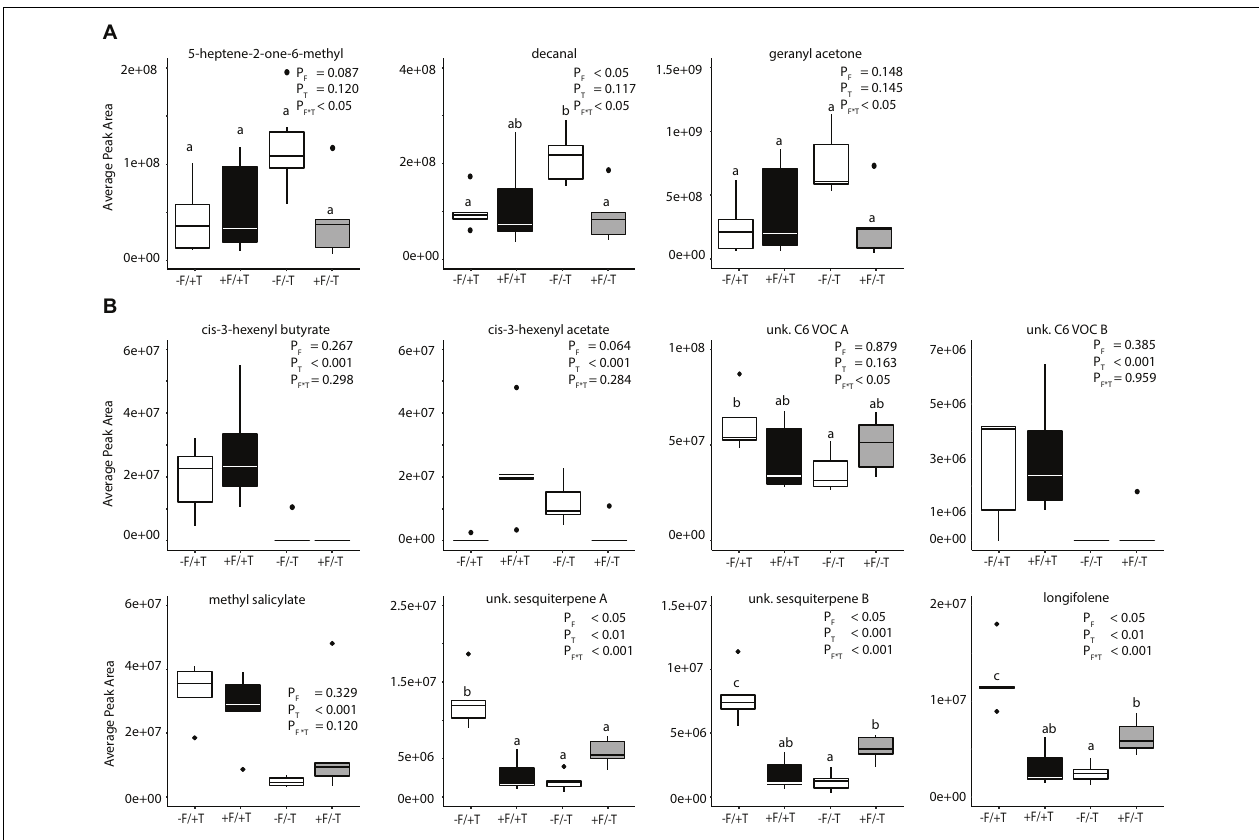
FIGURE 7 | Changes in volatile emissions from tomato plants colonized by the endophyte F. solani strain K (+F) and/or infested with spider mites ( T. urticae , +T). Boxplot of 11 compounds that showed high loading on PC 2. Treatments are: control plants –F/–T; FsK-colonized plants +F/–T; FsK- colonized and spider mite infested plants +F/+T; and only spider mite infested plants –F/+T (5–6 biological replicates per treatment). (A) Depicts compounds with negative loadings on PC 2 (treatment effect), while panel (B) depicts the compounds with positive loadings. Significant differences between treatments are indicated by different letters by Tukey’s post hoc tests after two-way ANOVA: P <